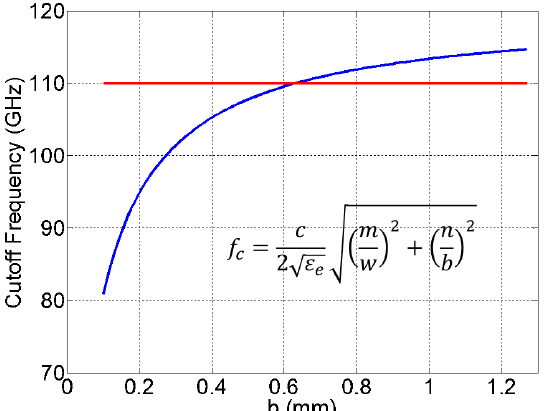
Figure 4. Cut-off frequency of the second mode of the GGW for channel heights. (Inset) Cut-off frequency expression, where c is the speed of light and m and n are the indexes of the TE mn mode, (2,0) in this case. The red line represents the upper limit of the